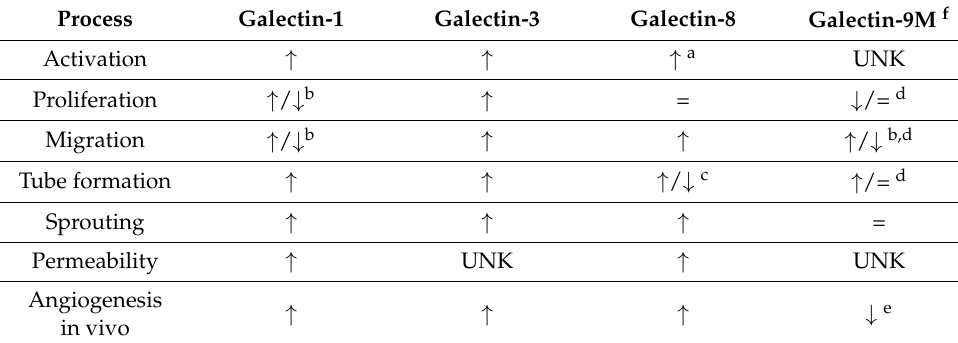
Table 2. Effect of galectins on endothelial cell function and angiogenesis